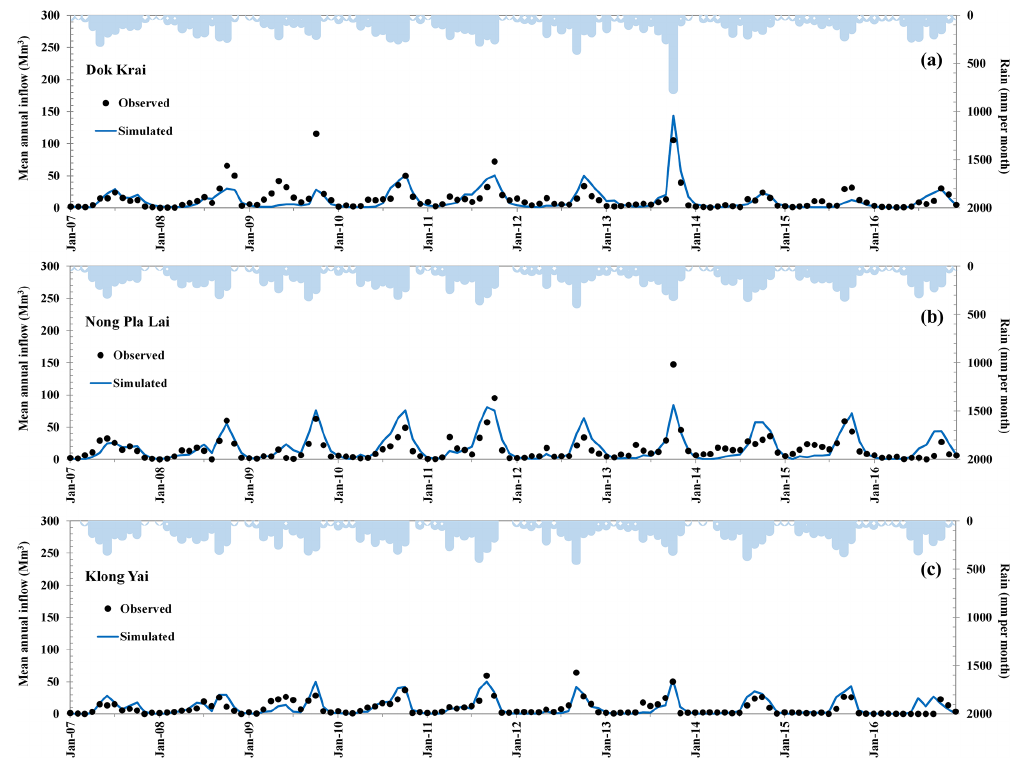
Figure 2. Calibrated inflow in 3 reserviors from SWAT model for the Klong Yai River basin.